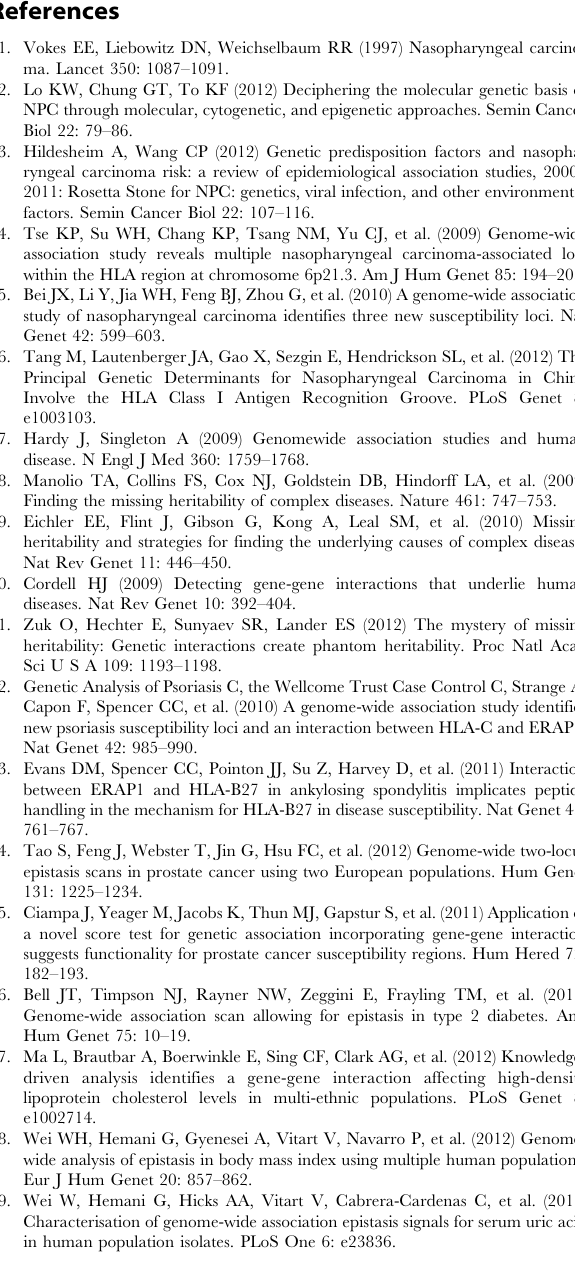
Table S2 Suggestive interactions associated with NPC suscep- tibility. (PDF) Table S3 Suggestive regions associated with NPC susceptibility. (PDF) Table S4 LD analysis of SNPs in interacting region. (PDF) Table S5 Haplotype analysis of the interaction regions located in the MHC region. (PDF) Table S6 Interaction P values for SNP pairs identified by other GWAS studies.